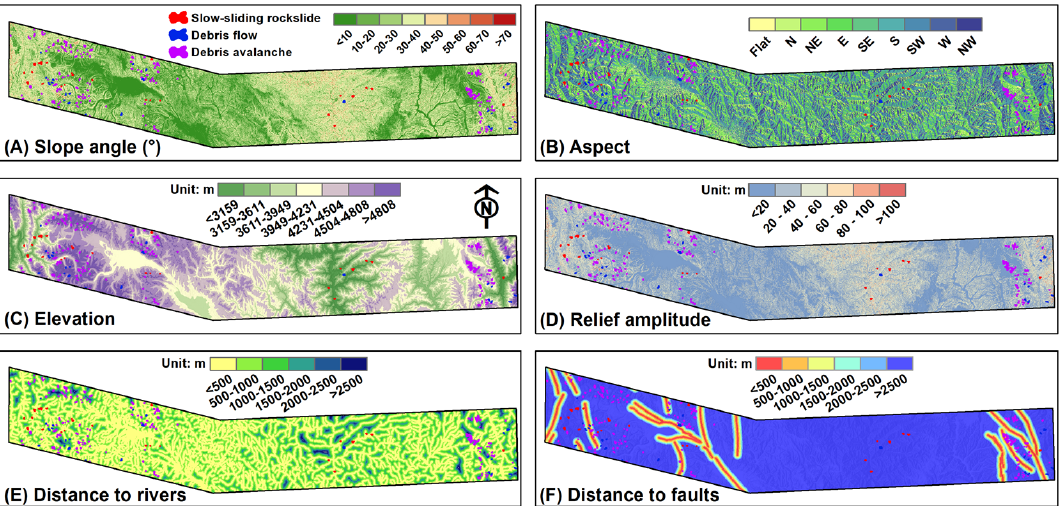
Figure 11. The landslide controlling factors: ( A ) slope angle, ( B ) aspect, ( C ) elevation, ( D ) relief amplitude, ( E ) distance to rivers, and ( F ) distance to faults.